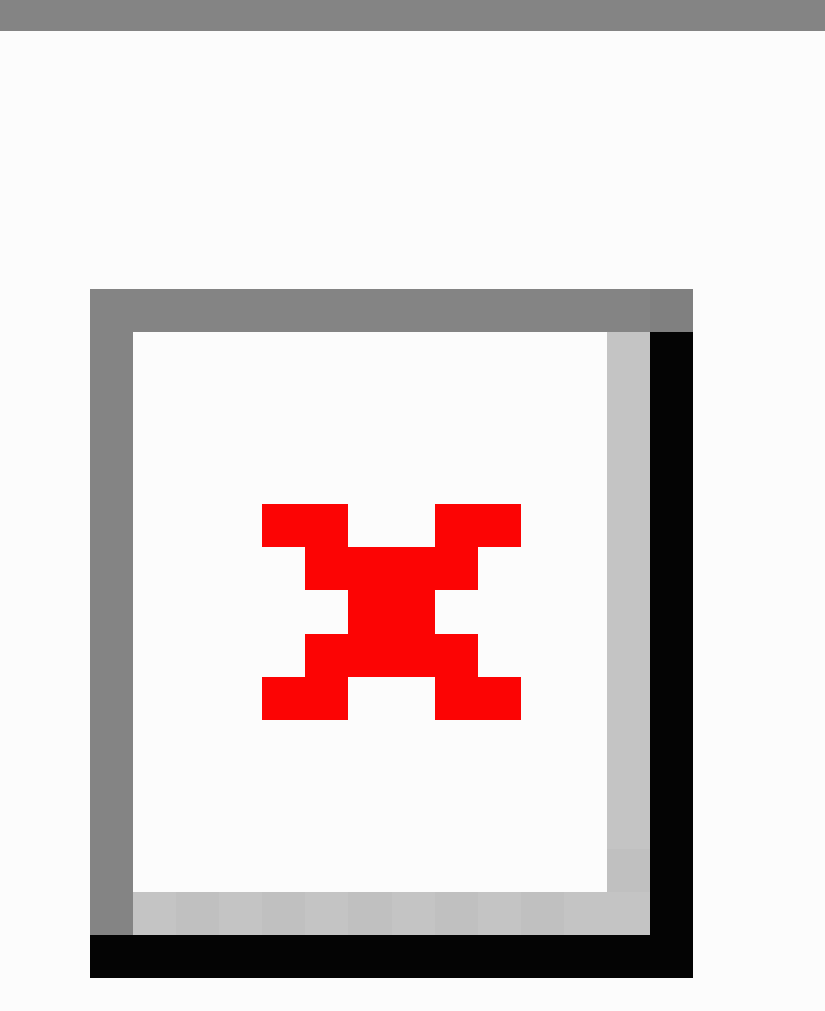
Figure 2. Box-and-whisker plot of recorded distances (half-marathon) by vendor: Garmin (n=77), Polar (n=72), Apple (n=20), TomTom (n=16), and Suunto (n=7). Vendors with less than 7 measurements were omitted. The dashed line indicates the reference distance of 21.0975